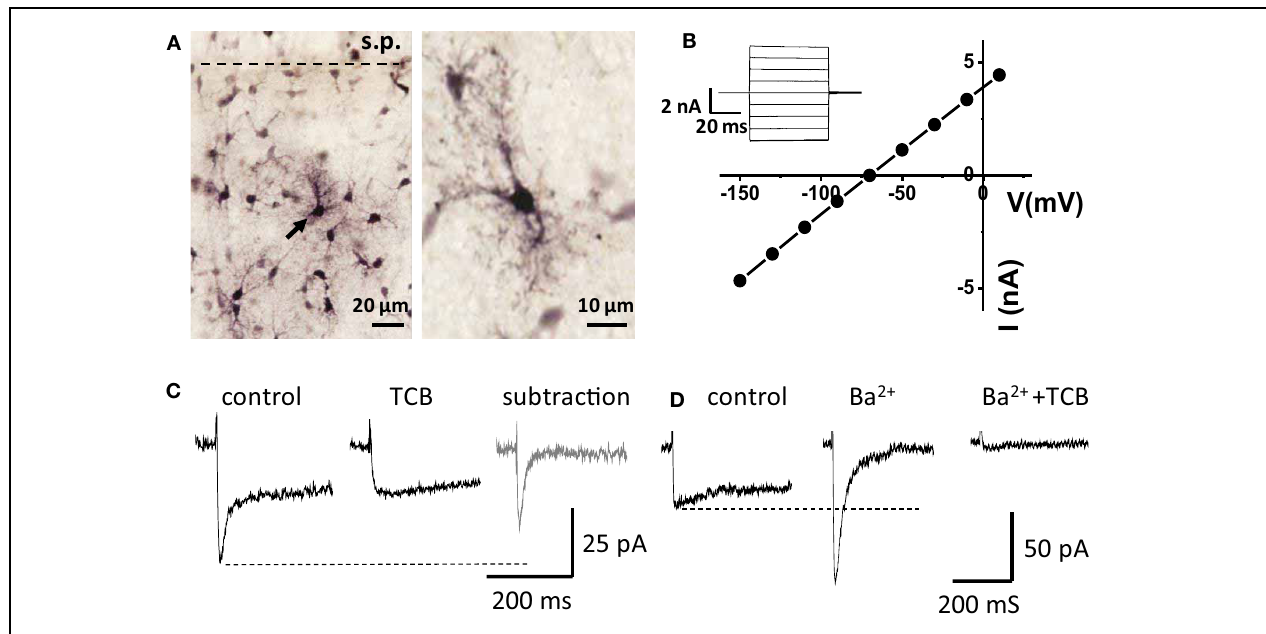
in control and in the presence of glutamate transporter current blockers (TCB). Gray trace —“pure” transporter current obtained by subtracting